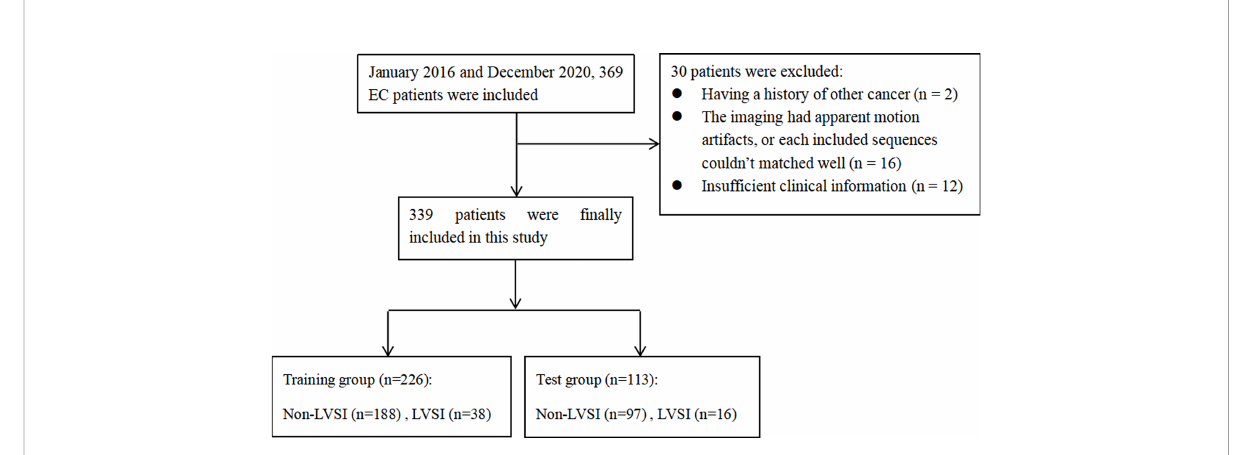
FIGURE 1 The work fl ow of this